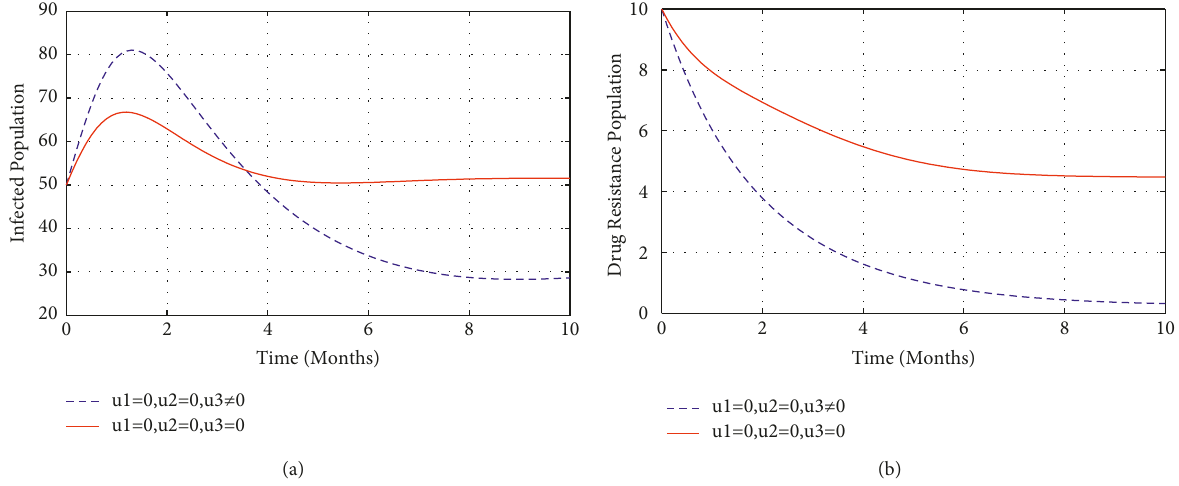
Figure 4: Impact of treatment of drug resistance on infectious and drug resistance populations.